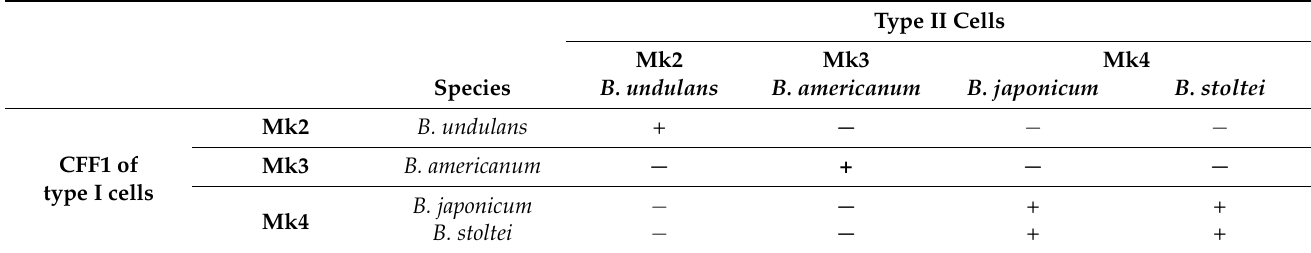
Table 2. Species-specific (or at least Mk-specific) pair inducibility of CFF1 from Blepharisma